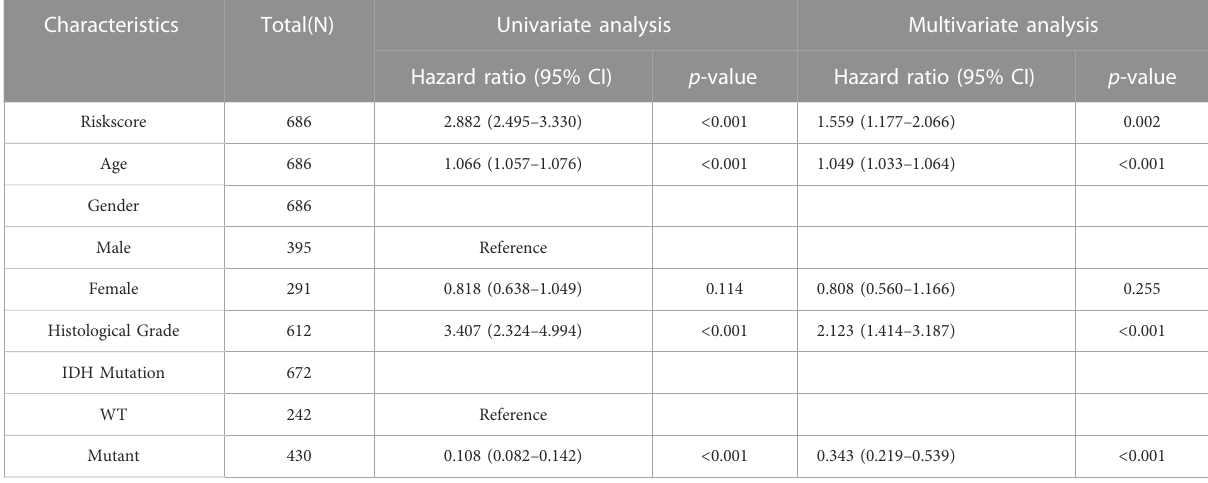
TABLE 4 The SIRT-Based signature and clinical features were analyzed by OS-based univariate and multivariate Cox regression in the TCGA database. Characteristics